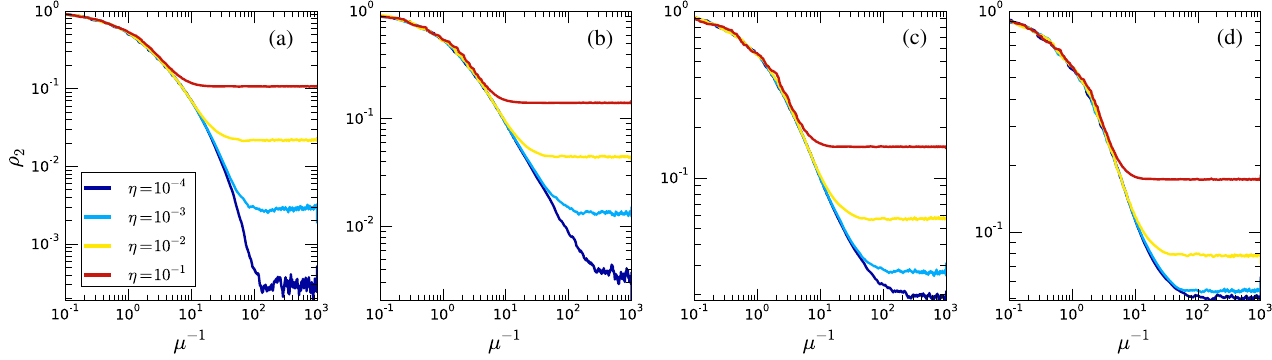
FIG. 7. Time evolution of the fraction of infected nodes in the second layer for μ ¼ 1 , different values of η ( 10 − 4 , 10 − 3 , 10 − 2 , and 10 − 1 ), and different values of the spreading rate: (a) λ ¼ 0 . 078 , (b) λ ¼ 0 . 083 , (c) λ ¼ 0 . 085 , and (d) λ ¼ 0 . 088 . The multiplex network used is composed of two Erdös-Rényi networks, both with n ¼ 5 × 10 4 — the first layer with h k i ¼ 16 [ ð Λ 1 1 Þ − 1 ≈ 0 . 0625 ] and the second with h k i ¼ 12 [ ð Λ 2 1 Þ − 1 ≈ 0 . 0833